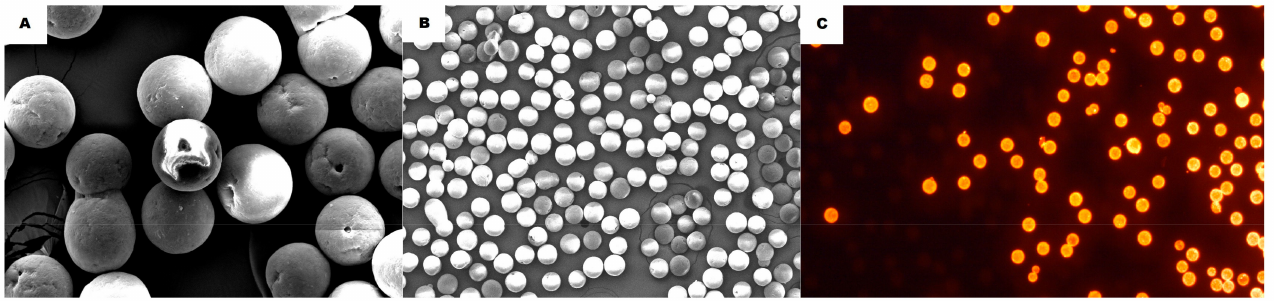
Figure 1. ( A , B ) images from SEM showing the morphology of the PE-MPs (magnification ( A )—500 × , ( B )—370 × ). ( C ) shows the fluorescence of the PE-MPs in shape of beads (magnification 100 ×